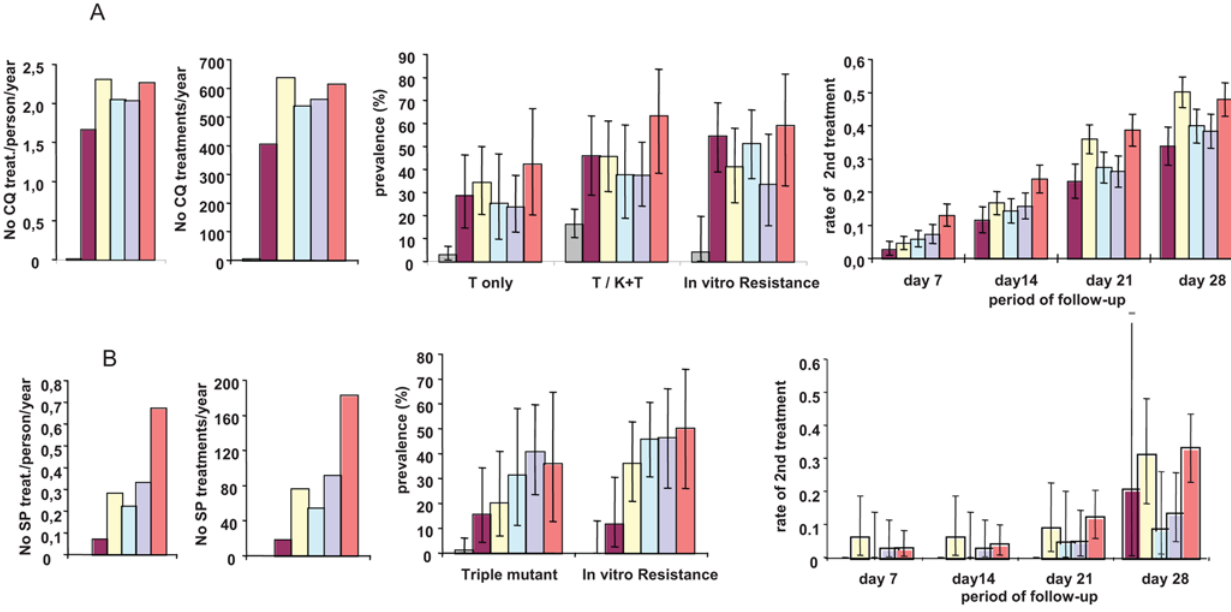
Figure 6. Temporal distribution of CQ and SP drug pressure and drug resistance in Dielmo in 1990–9. The drug pressure is expressed as No of treatments/person/year (first graph) and as overall No of treatment courses administered per year (second graph). Panels A and B refer to CQ and SP, respectively. The prevalence of the Pfcrt mutant alleles was calculated from molecular beacon studies (N=324) (see Figure 2), while the prevalence of the Pfdhfr-ts triple mutant was calculated from the full gene sequences available (N=202) (see Figure 3). In vitro susceptibility assays were carried out in 1990–4 during the rainy season (N=26) and from 1995 onwards for the last 2–3 months of the year, namely from 7/11/1995–26/12/1995 (N=46) ; 6/01/1996–3/12/1996 (N=59); 27/10/97–15/121997 (N=26) ; 10/01/1998–15/11/1998 (N=54) and 29/09/1999–08/11/1999 (N=25). The proportion of interpretable CQ and pyrimethamine susceptibility tests was 68–81% and 72–81%, respectively, depending on the year. The prevalence of resistance is expressed as the percent of interpretable assays presenting a CI 50 for CQ . 100 nM or a CI 50 for pyrimethamine . 2000 nM. The occurrence of a second clinical malaria episode within 7, 14, 21 and 28 days of treatment was calculated as described in Materials and Methods. The bars correspond to the 95% confidence interval. The years before implementation of CQ and SP (1990–4) are grouped together. A. CQ pressure, Pfcrt 76T resistance mutation, CQ in vitro resistance and prevalence of clinical attacks following a CQ